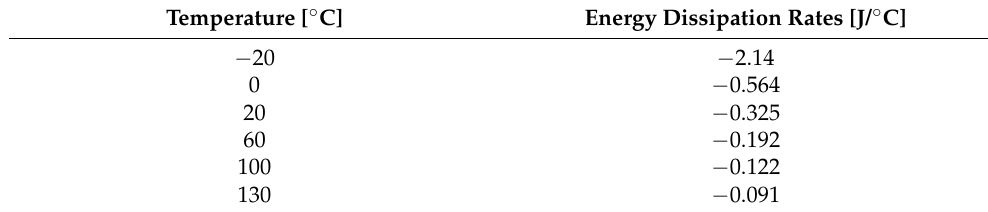
Figure 9. Energy dissipated in one cycle. Table 2. Temperature dependence of the energy dissipation rate. Table 2. Temperature dependence of the energy dissipation